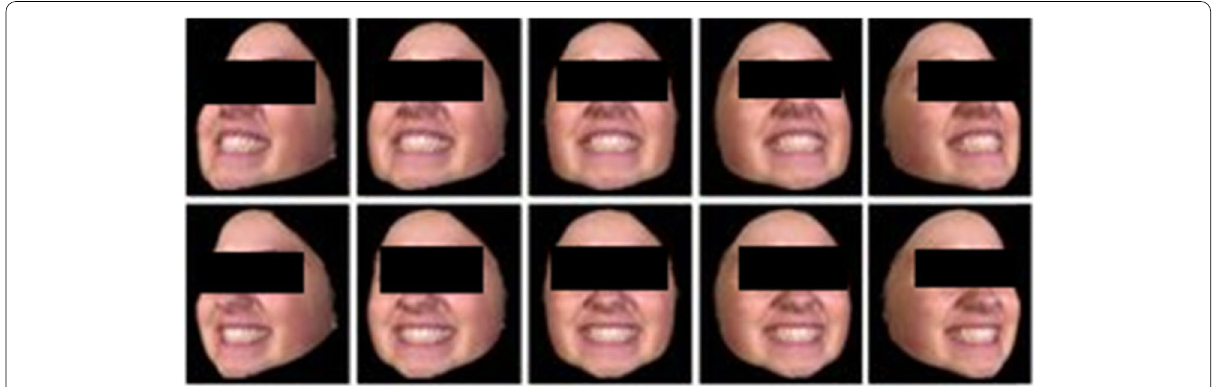
Fig. 7 Sample BU3DFE